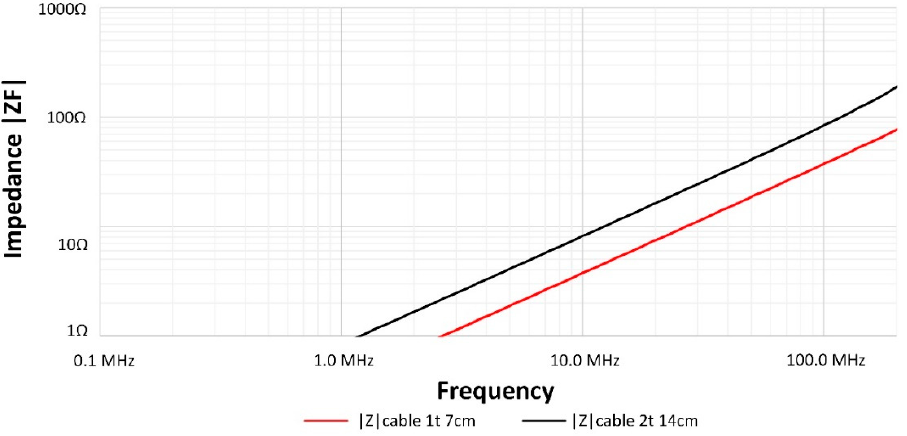
Figure 6. Magnitude of the impedance of the AWG26 (American Wire Gauge) wires used to measure the impedance of the sleeve ferrite cores.